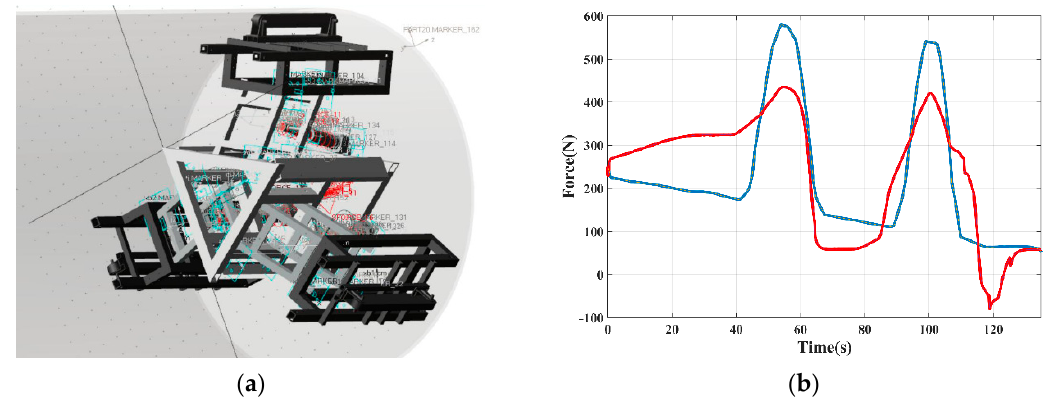
Figure 13. Independent adjustment analysis. ( a ) prototype in Adams; ( b ) feedback of the supporting force on one crawler in two ways.